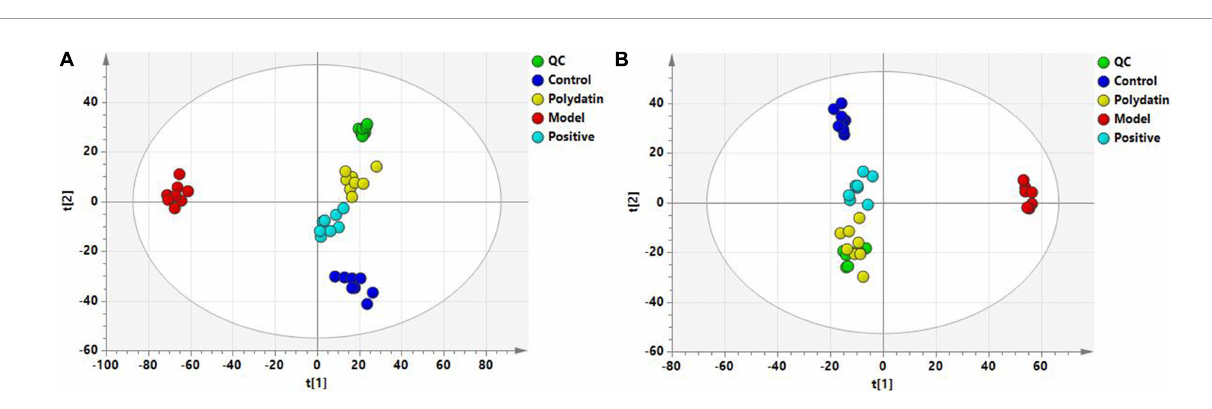
FIGURE3 PCA score plots of QC and four groups based on serum metabolic profiles (A) ESI + mode; (B) ESI −